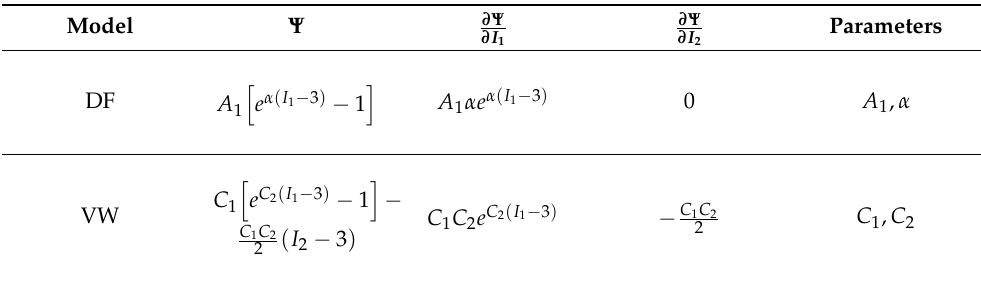
Table 1. A summary of strain-energy density functions, and the parameters to be calculated for material models of DF and VW [21,23].